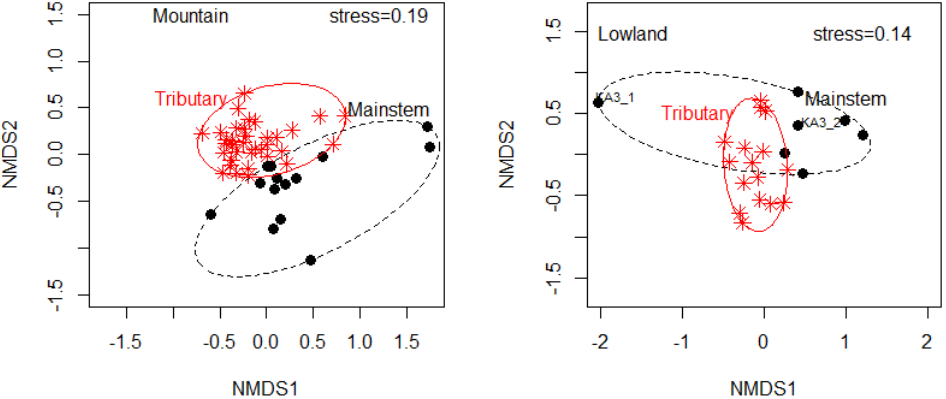
Figure 7. Non-metric multidimensional scaling (NMDS) plot based on benthic macroinvertebrates assemblages across sites in Mountain and Lowland. Symbols indicate river types: the river’s mainstem and the tributaries.KA3_1 and KA3_2: sample code of a site in the river’s mainstem for pre-monsoon and post-monsoon seasons, respectively, indicating high seasonal variability for the site.